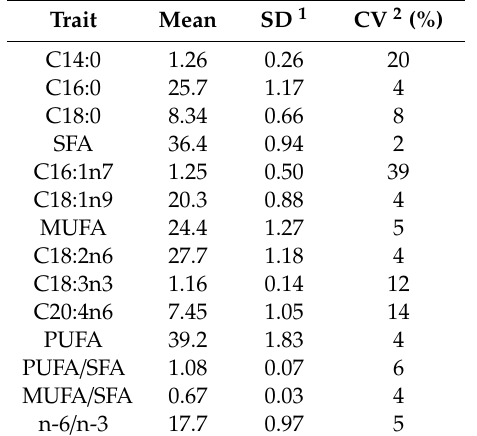
Table 1. Descriptive statistics for fatty acids (% of total fatty acids) of Longissimus thoracis et lumborum muscle in rabbits. Trait Mean SD 1 CV 2 (%) C14:0 1.26 0.26 20 C16:0